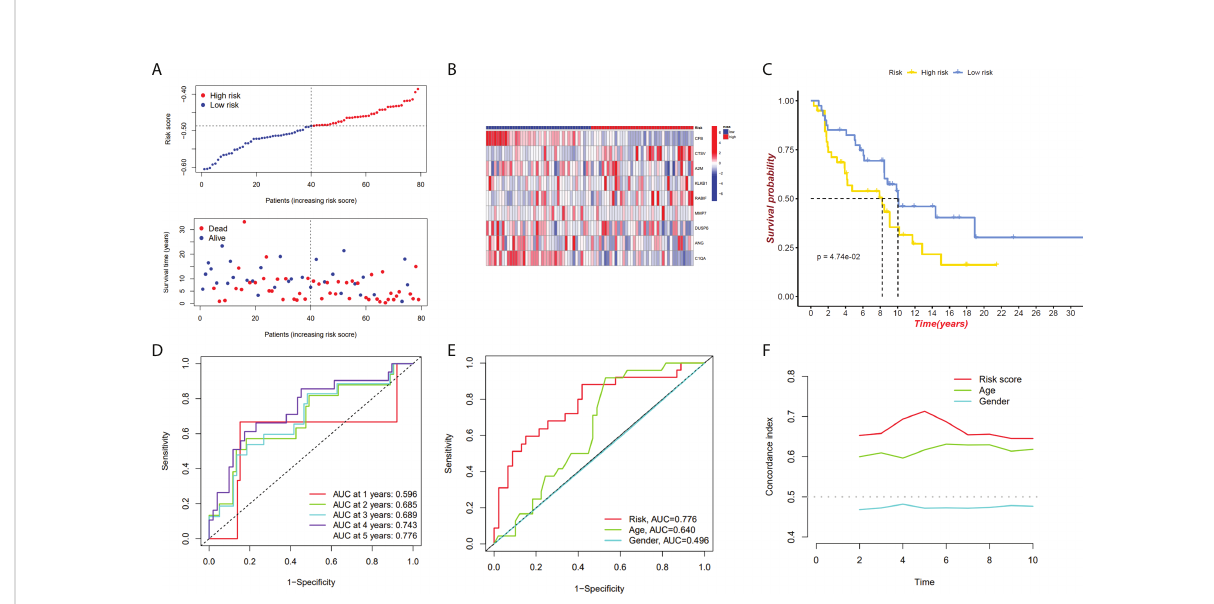
FIGURE 4 GEO cohort validate prognostic model. (A, B) GEO cohort risk score distribution, survival data, and gene expression heat map. (C) The GEO cohort ’ s high-risk and low-risk Kaplan – Meier curves. (D) The risk model ’ s 1-, 3-, and 5-year OS AUCs under ROC curves. (E) ROC linking risk scores to pathological markers. (F) C-index comparison between risk score and clinical feature (age and